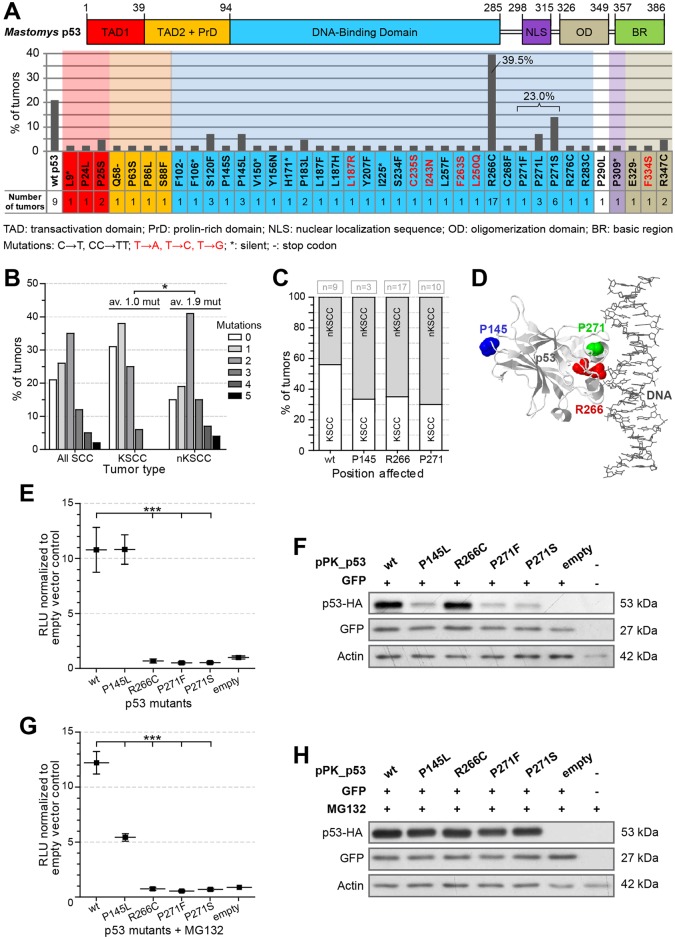
Analysis of the Trp53 status in UV-induced SCCs.A) Schematic structure of Mastomys coucha p53 (based on [113]) matched to the position and the frequency of mutated residues (n = 43). Note that residue P271 was substituted by three different amino acids. B) Comparison of the number of Trp53 mutations in KSCCs (n = 16), nKSCCs (n = 27) and the total number of SCCs (n = 43) (unpaired t-test, p = 0.0227). C) Frequency of mutations at positions P145, R266 and P271 in KSCCs in comparison to nKSCCs. D) Locations of the hot-spot mutations in a 3D model of p53. Selected residues are highlighted (source: http://p53.iarc.fr/MakeJMol.aspx). E) Hot-spot mutants were cloned in an expression vector and tested for their capacity to transactivate a p53-responsive firefly luciferase gene. Transactivation activity was measured by luminescence (RLU, relative light units). Cells transfected with empty vector served as control and their RLU levels were arbitrarily set to 1 (Mean ± SEM; n = 7; 1way-ANOVA, ***p<0.001). F) Western blot showing protein levels of p53 mutants measured in the transactivation assay. EGFP was used as a control for transfection efficiency, actin as an internal loading control. G) Same as shown in panel E. Prior to the measurement of the transactivation, transfected cells were treated with 5 μM MG132 (Mean ± SEM; n = 4; 1way-ANOVA, ***p<0.001). H) Western blot of transfected cells after treatment with 5 μM MG132.